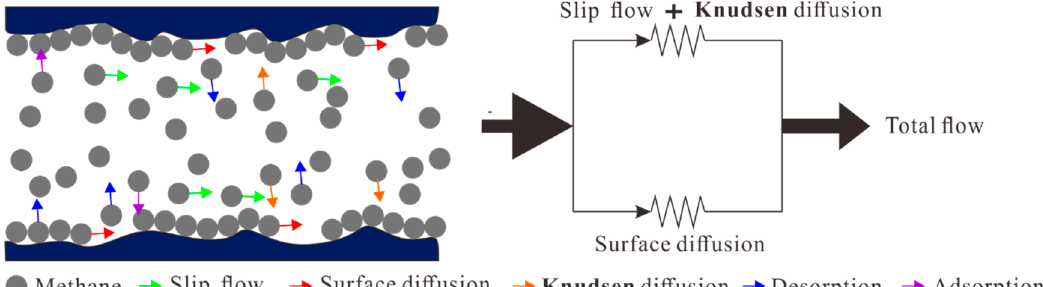
Figure 2. Multi-scale flow mechanism in shale nanopores.